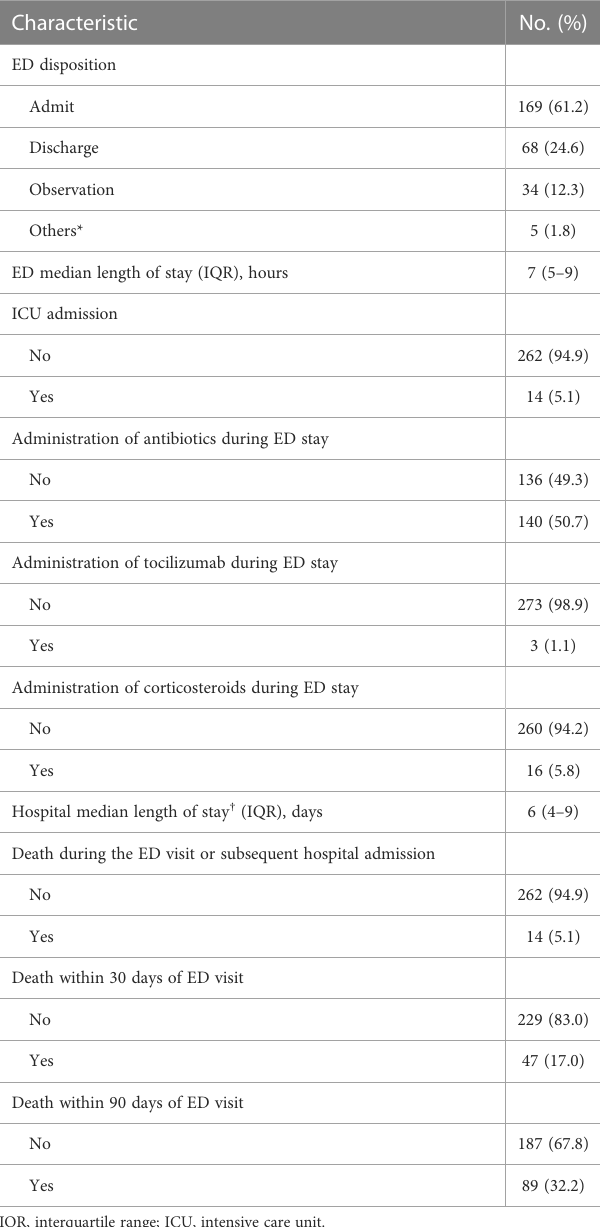
TABLE 3 Outcomes of emergency department (ED) visits for cancer patients in our analysis who had received chimeric antigen receptor T-cell infusion therapy within the past 6 months (total number of visits =